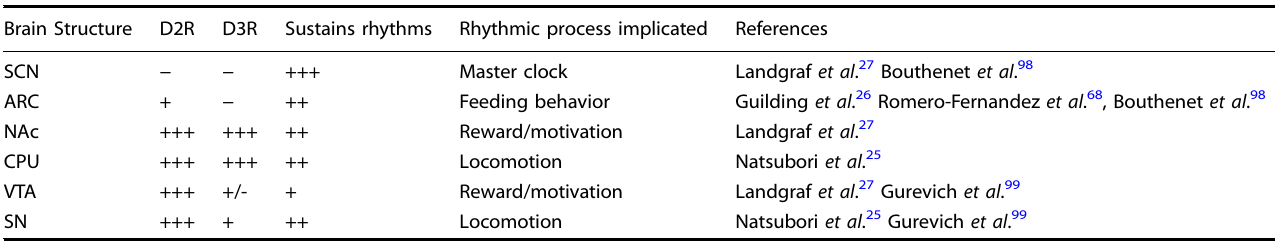
Table 1. D2R and D3R expression pro fi les in brain regions that exhibit 24-h clock gene oscillations Brain